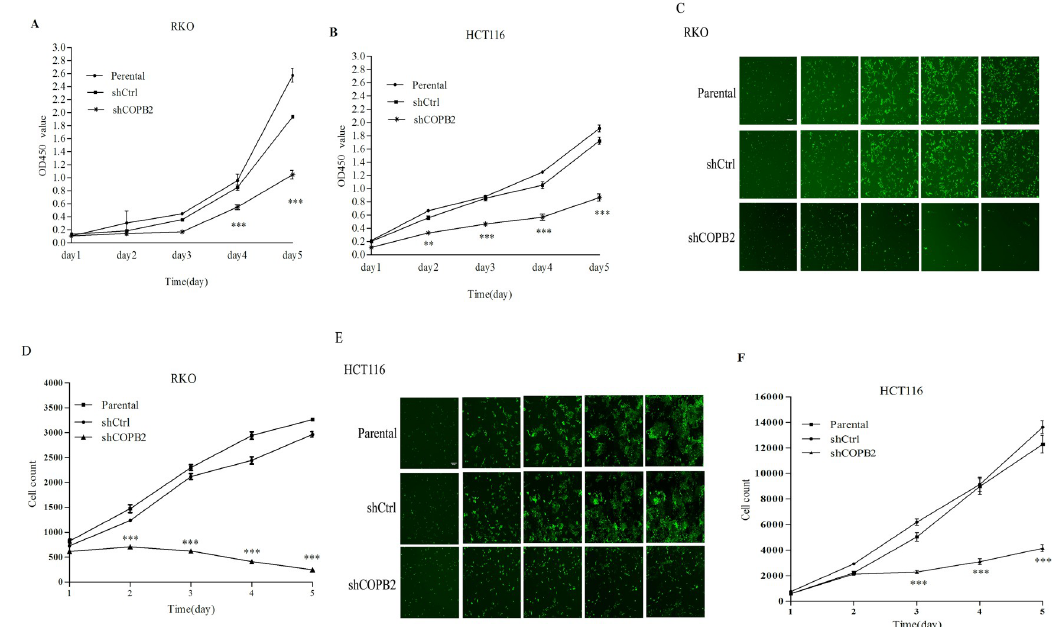
Fig 4. COPB2 knockdown suppresses the proliferation of RKO and HCT116 cells. ( A-B ) The proliferative capacity of parental cells, shCtrl-treated cells, and shCOPB2-treated cells were measured via CCK8 assays. After incubation for 48 or 96 hours, the proliferative capacity of shCOPB2-treated cells were decreased in RKO and HCT116 cells. ( C-F ) Celigo cell counting assays indicated that the proliferation was significantly reduced when COPB2 expression was inhibited. Data are shown as the mean ± SD. �� P < 0.01, ��� P < 0.001, compared with shCtrl and parental cells.